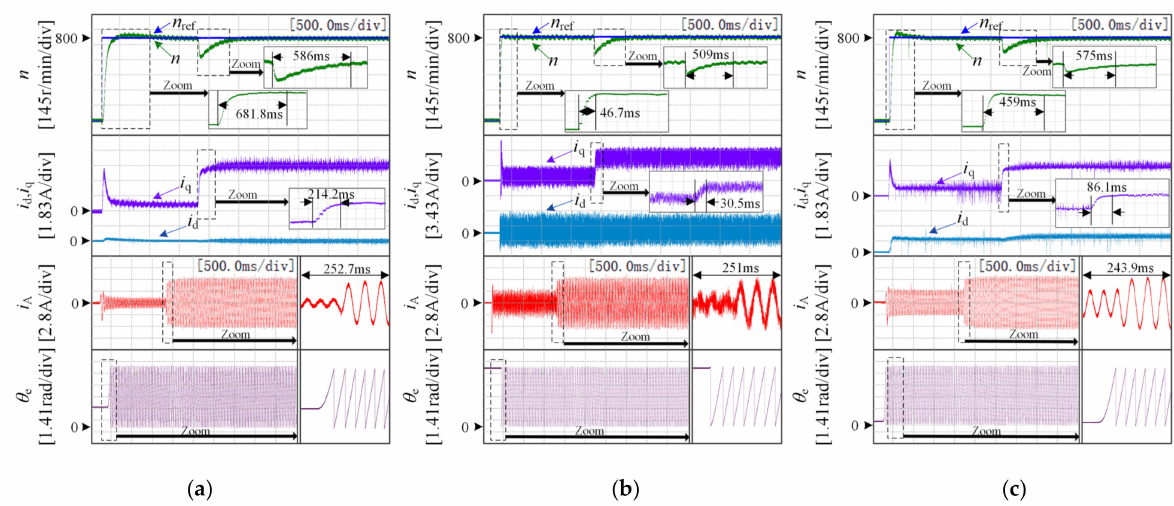
Figure 5. Comparison results of the proposed algorithm with FOC and PSC; all strategies are not equipped with observers. ( a ) FOC. ( b ) PSC. ( c ) NPSC.